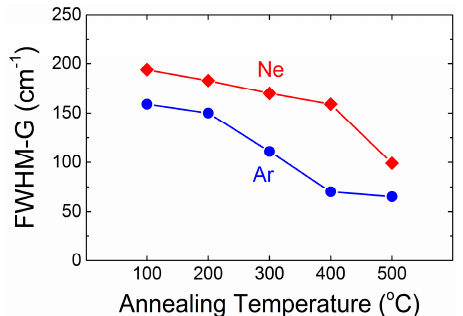
Figure 2. The full-width at half-maximum of the G-peak measured after annealing the Ne- and Ar- HiPIMS films deposited with a bias voltage of − 200 V.